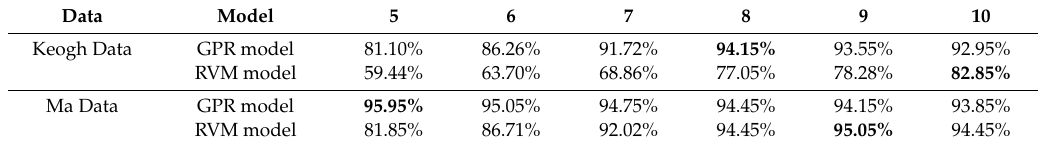
Table 2. The true skill statistic (TSS) with the Markov chain under different sliding window